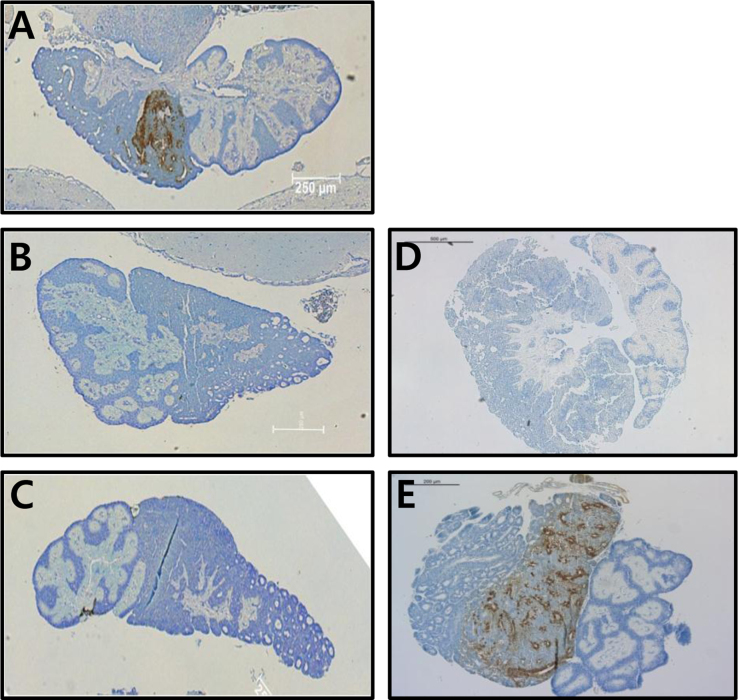
Localization of FSHβ-subunit expression in the eel pituitary during oocyte-maturation. Adjacent sections of the pituitary were stained with eFA-C14, an antiboy that specifically binds to eel FSHβ-subunit, and detection was performed using swine anti-mouse IgG secondary antibodies (1:1000). Representative IHC analyses are shown. The staining revealed the specific site of FSHβ-subunit in the pituitary. (A) GSI>0.5%; (B) 5.7%; (C) 33.8% (immediately before ovulation); (D) immediately after ovulation; (E) on Day 7 after ovulation.